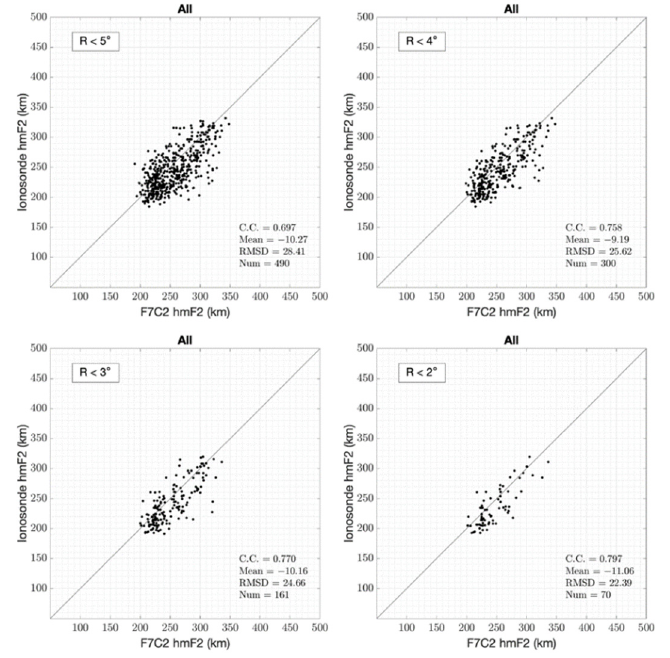
Figure 13. Same as Figure 12, but for hmF2.